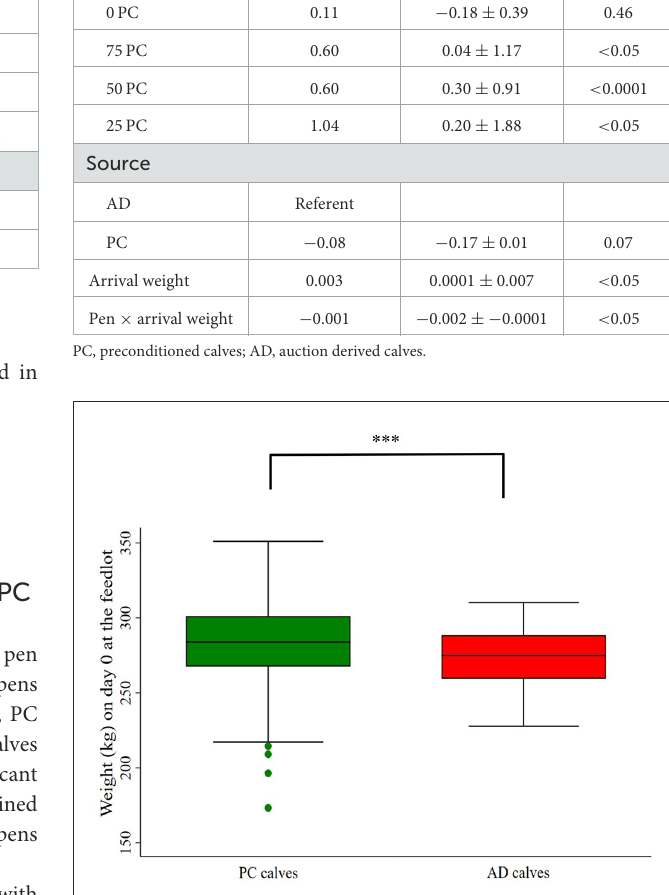
0 PC had higher morbidity than AD calves in 25PC (OR = 0.37, P <